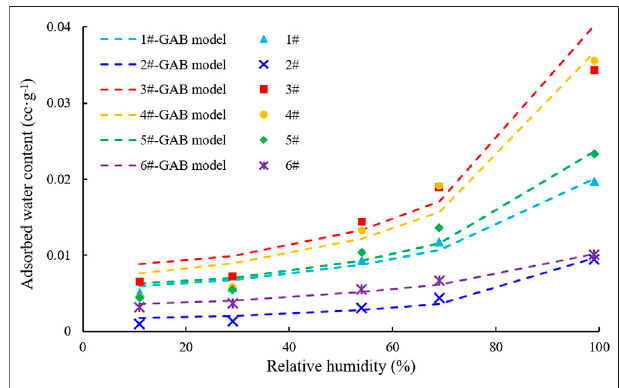
FIGURE 3 | Fitted curve of the GAB model for samples with different equilibrium